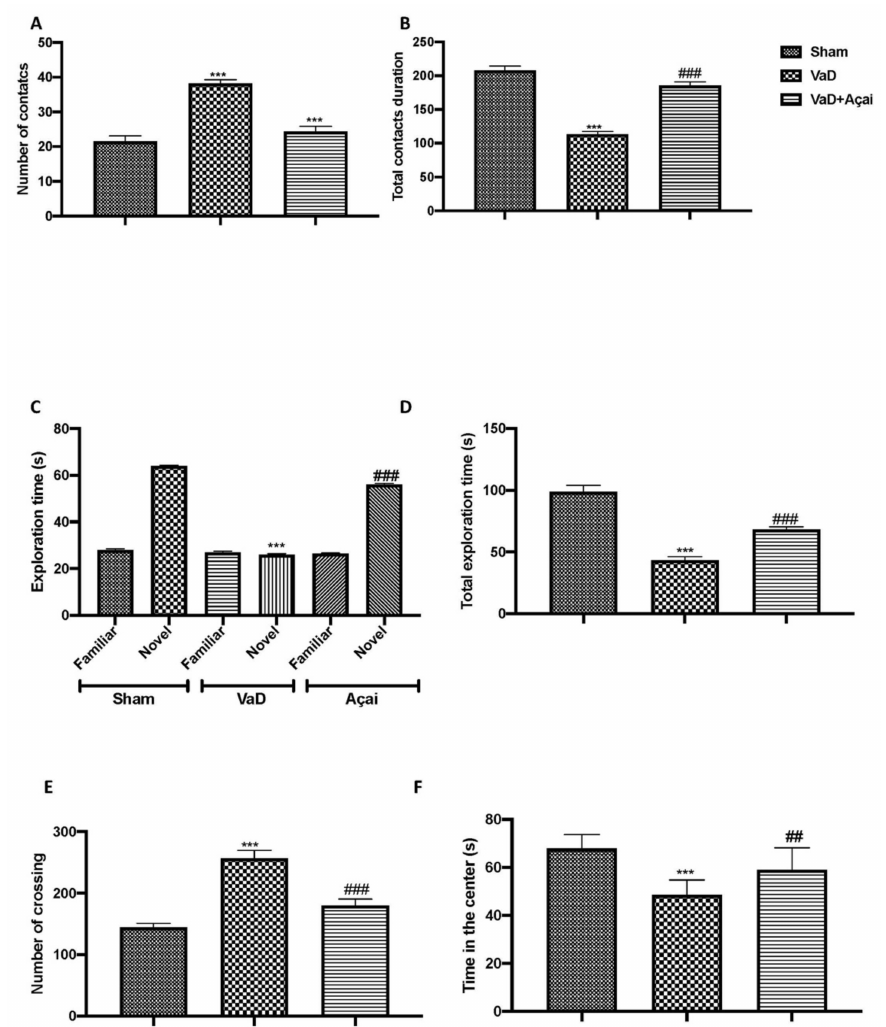
Figure 1. Açai berry improves vascular-dementia-induced behavioral changes. ( A ) Number of contacts and ( B ) total contact duration measured during social interaction test; ( C ) time spent to explore familiar or novel object, and ( D ) total exploration time measured during novel object recognition test; ( E ) number of crossing and ( F ) time in the center measured during open field test. Values are means ± SEM of six mice for all groups. See manuscript for further details. *** p < 0.001 vs. sham; ### p < 0.001 vs. VaD; ## p < 0.01 vs.